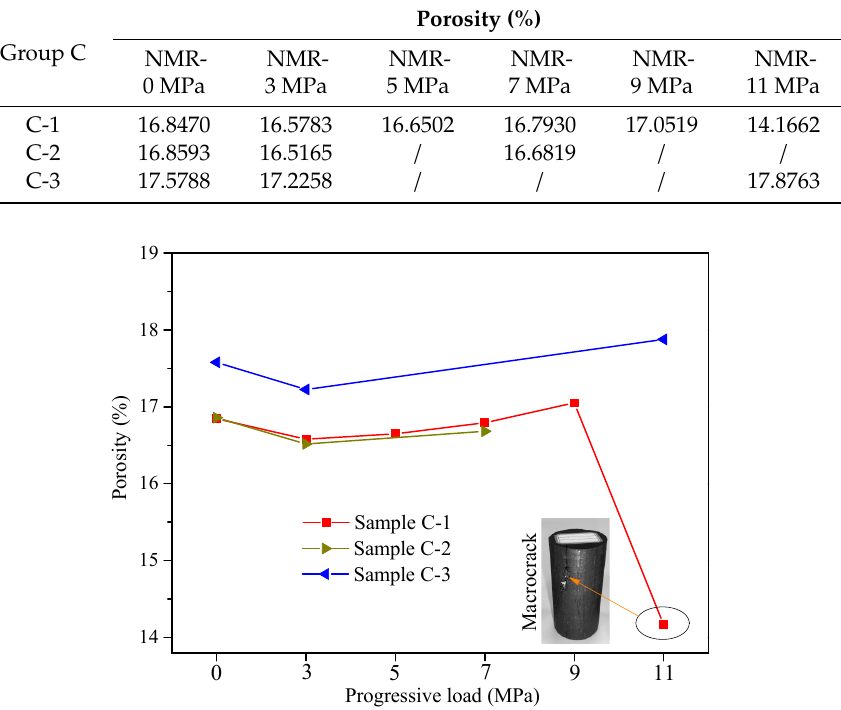
Figure 8. Porosity evolution of the coal samples in Group C under progressive loads.